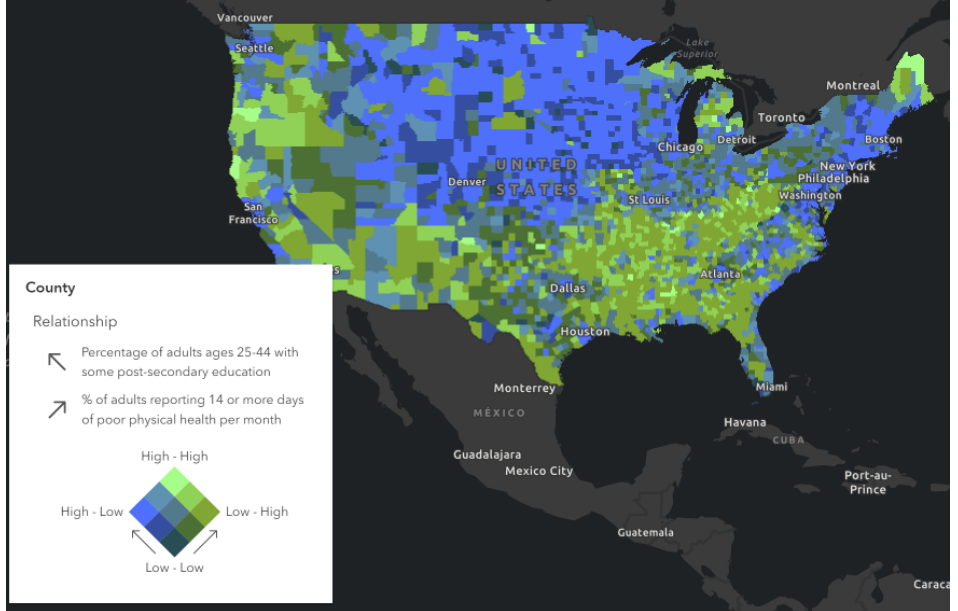
Figure 8. Ratio of percentage of individuals between the ages of 25–44 with at least some college education to percentage of adults reporting 14 or more days of poor physical health per month (dark green = poor physical health/poor education) and can be viewed in the following link https: //arcg.is/1GDnuP1 (created on 15 June